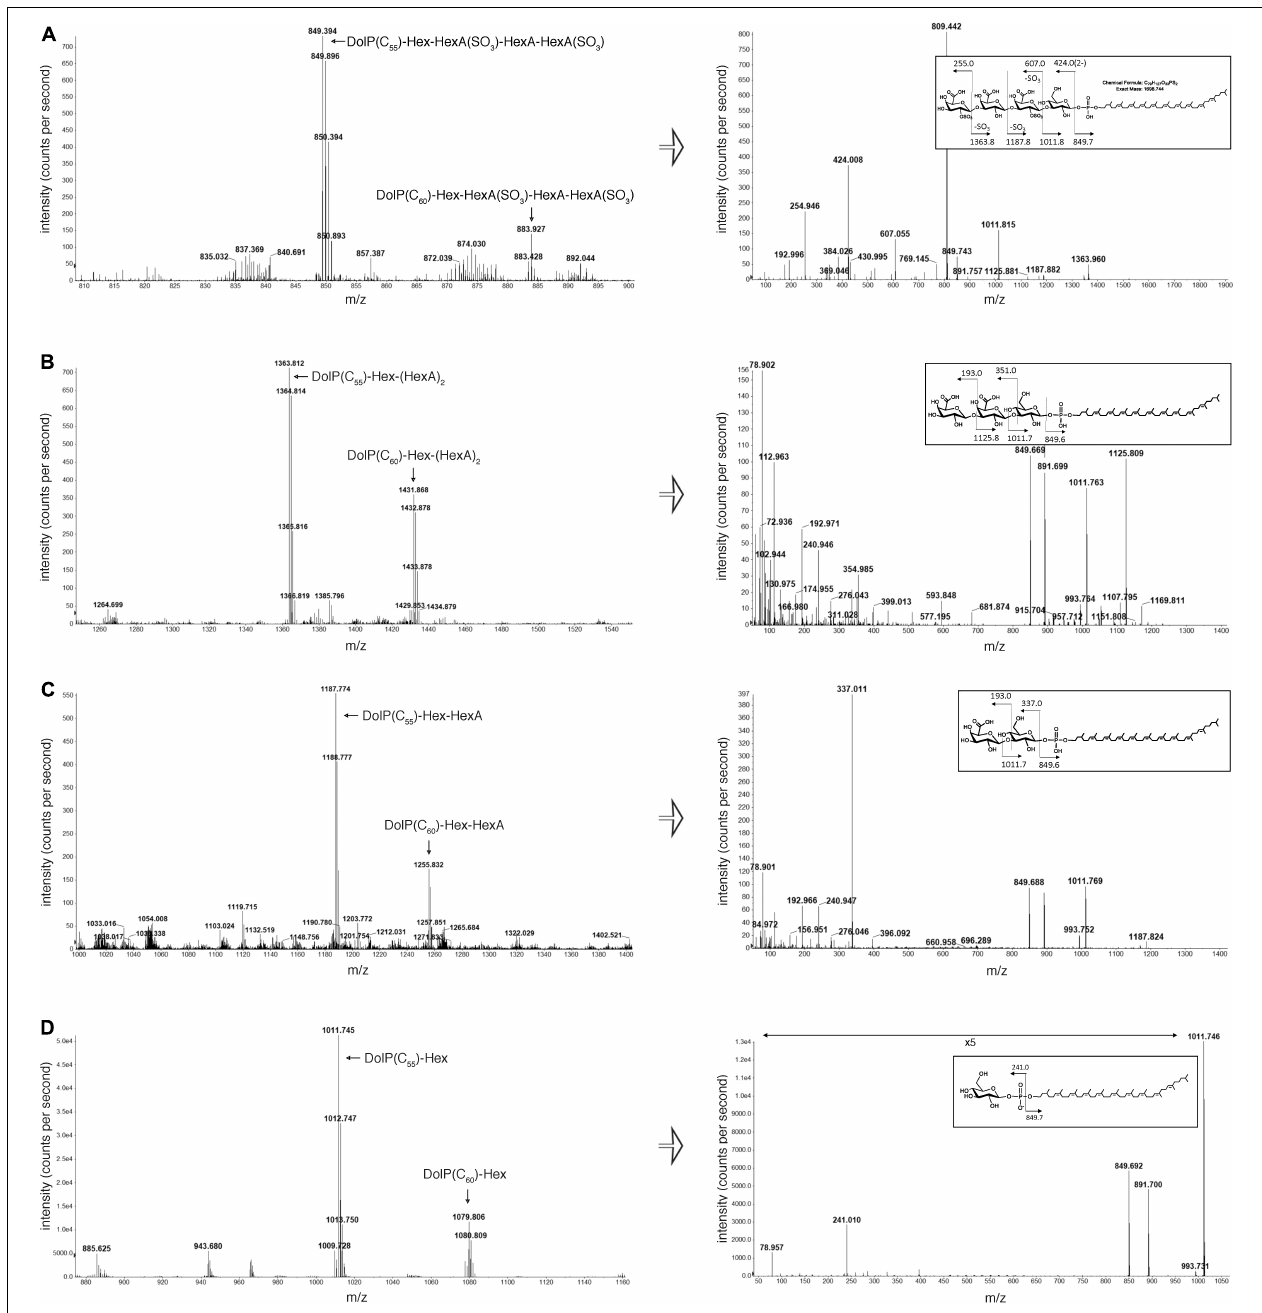
FIGURE 4 | DolP-bound glycans are truncated in cells lacking vng1062G, vng1066C or vng1067G . (A) LC-ESI MS analysis of a total lipid extract from parent strain cells includes peaks corresponding to the doubly charged parent ion ([M-2H] 2 − ) of C 55 - and C 60 -DolP modified by a hexose, a hexuronic acid and two sulfated hexuronic acids (left panel). Right panel: MS/MS profile of the tetrasaccharide-bearing C 55 -DolP moiety includes peaks predicted by the breakdown map of this glycosylated lipid (inset). MS/MS was performed on the doubly charged parent ion ([M-2H] 2 − ) at m/z 849.39. (B) LC-ESI MS analysis of a total lipid extract from (cid:49) vng1062G strain cells includes peaks corresponding to C 55 - and C 60 -DolP modified by a hexose and two hexuronic acids (left panel). Right panel: MS/MS profile of the trisaccharide-bearing C 55 -DolP moiety includes peaks predicted by the breakdown map of this glycosylated lipid (inset). MS/MS was performed on the doubly charged parent ion ([M-2H] 2 − ) at m/z 681.7. (C) LC-ESI MS analysis of a total lipid extract from (cid:49) vng1066C strain cells includes peaks corresponding to C 55 - and C 60 -DolP modified by a hexose and a hexuronic acid (left panel). Right panel: MS/MS profile of the disaccharide-bearing C 55 -DolP moiety includes peaks predicted by the breakdown map of this glycosylated lipid (inset). (D) LC-ESI MS analysis of a total lipid extract from (cid:49) vng1067G strain cells includes peaks corresponding to C 55 - and C 60 -DolP modified by a hexose (left panel). Right panel: MS/MS profile of the hexose-bearing C 55 -DolP moiety includes peaks predicted by the breakdown map of this glycosylated lipid (inset). The arrow indicating × 5 in the MS/MS profile from the (cid:49) vng1067G strain cells (bottom right panel) reflects magnification of the ion peaks in the corresponding region of the m/z values on the